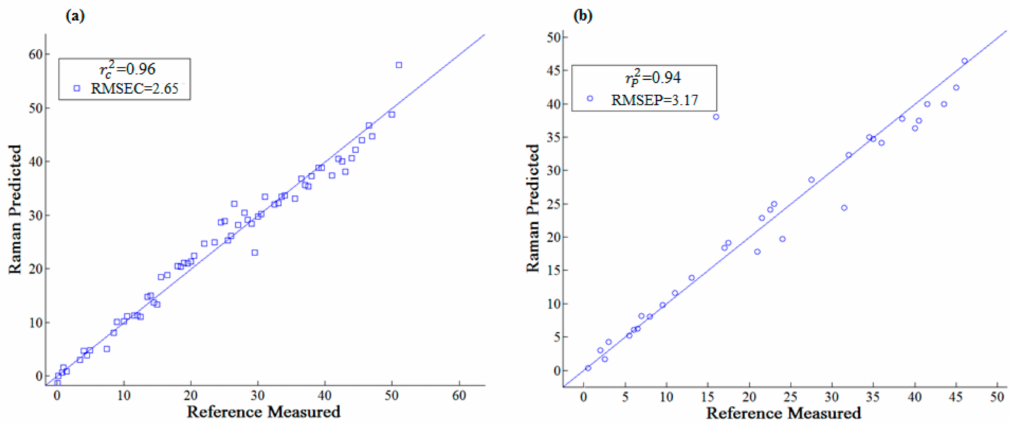
Figure 8. Scatter diagram of calibration set and prediction set by 1st-Der: ( a ) Calibration set; ( b ) prediction